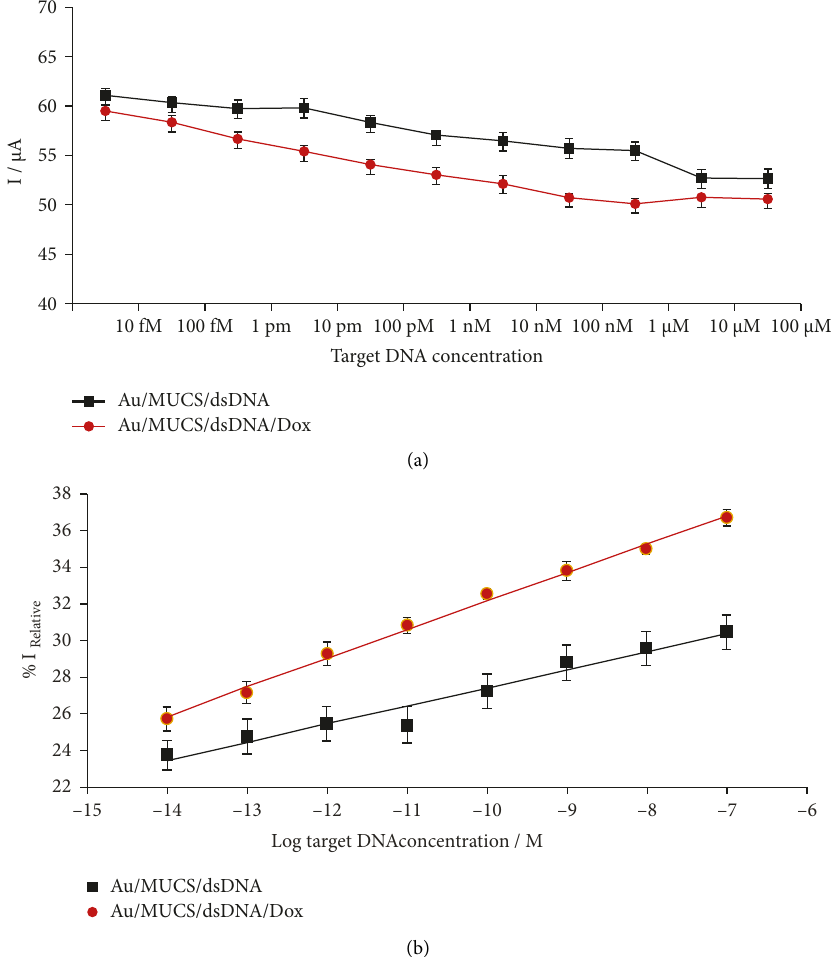
Figure 3: (a) Anodic peak current for [Fe(CN) 3 − /4 − redox probe recorded at Au/MUCS/dsDNA and Au/MUCS/dsDNA/dox elec- 6 ] trodes, in different concentration of target DNA, respectively. (b) Linear relationship between the relative current change of the anodic peak [Fe(CN) 6 ] 3 − /4 − redox probe and the logarithm of the target DNA concentration at Au/MUCS/dsDNA and Au/MUCS/dsDNA/Dox electrodes,